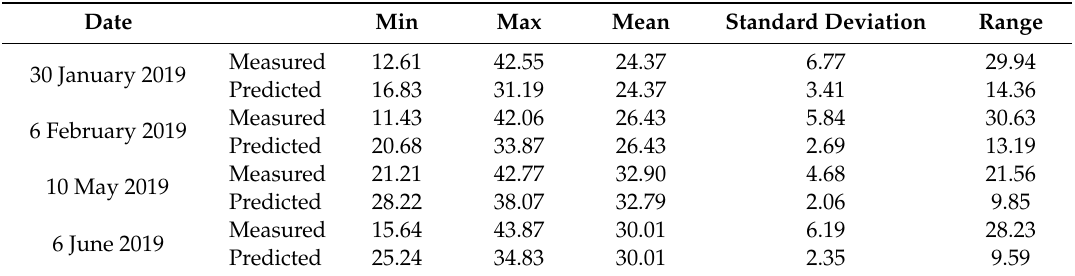
Table 5. Statistics of measured and predicted soil moisture.